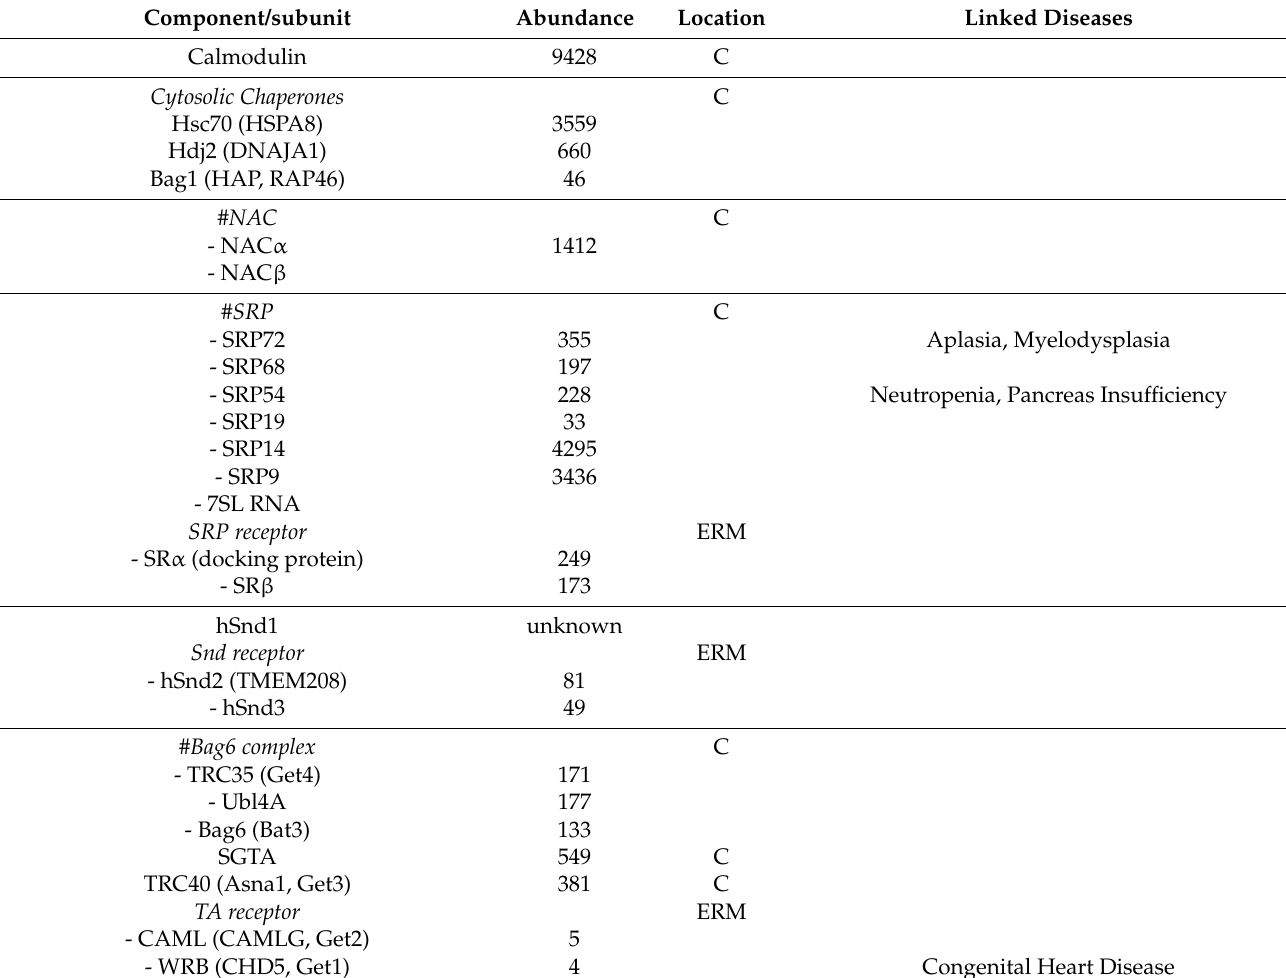
Table 1. Protein transport components/ complexes and associated proteins in HeLa cells. Component/subunit Abundance Location Linked Diseases